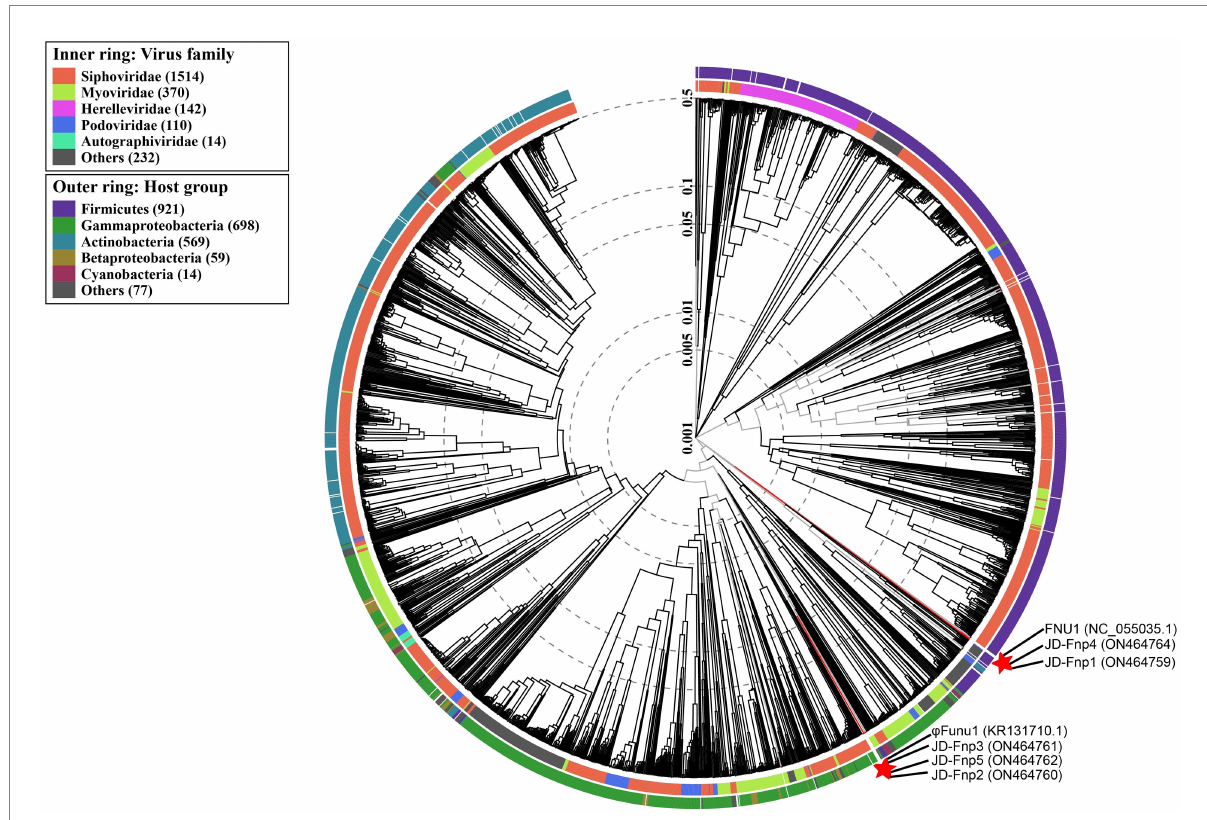
FIGURE 9 Phylogenetic tree of JD-Fnp1 ~ JD-Fnp5 and relative bacteriophages based on the complete genome sequences. The genome sequences of two F. nucleatum phages reported previously were downloaded from NCBI, and all the accession numbers are shown in () following the names of phages. The phylogenetic tree was constructed with VipTree (http://www.genome.jp/viptree) based on whole genome sequences at DNA